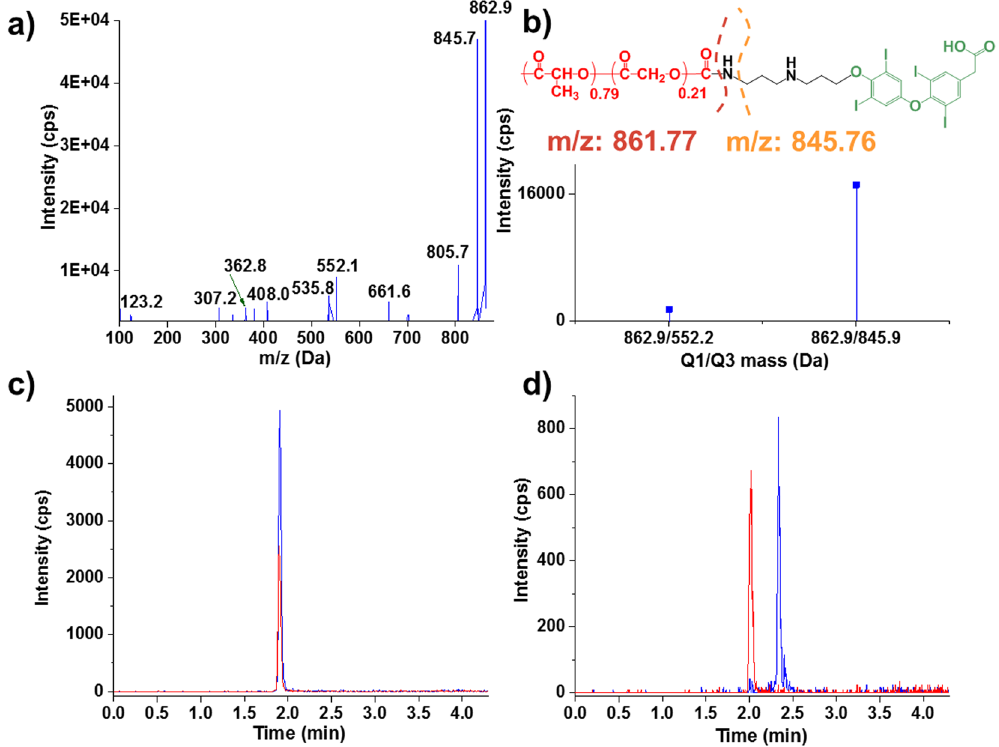
Figure 6. ( a ) Mass spectrum of DAT. ( b ) MRM transitions of PLGA-DAT after an in-source fragmentation. ( c ) LC-MS/MS chromatogram of DAT (blue) and deuterium-labelled DAT-D7 (red) as internal standard. ( d ) LC-MS/MS chromatogram of PLGA-DAT (blue) and DAT-D7